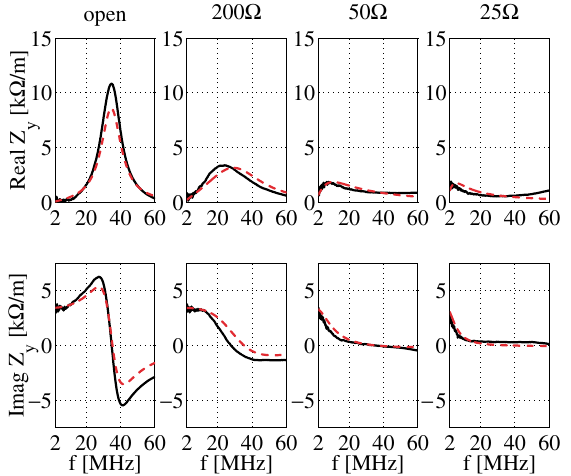
FIG. 6. (Color) Vertical coupling impedance due to the coupled-flux contribution. The solid (black) curves are mea- sured impedances minus the measurement of the short-circuit termination at the busbar and the dashed (red) curves are calculated model values.